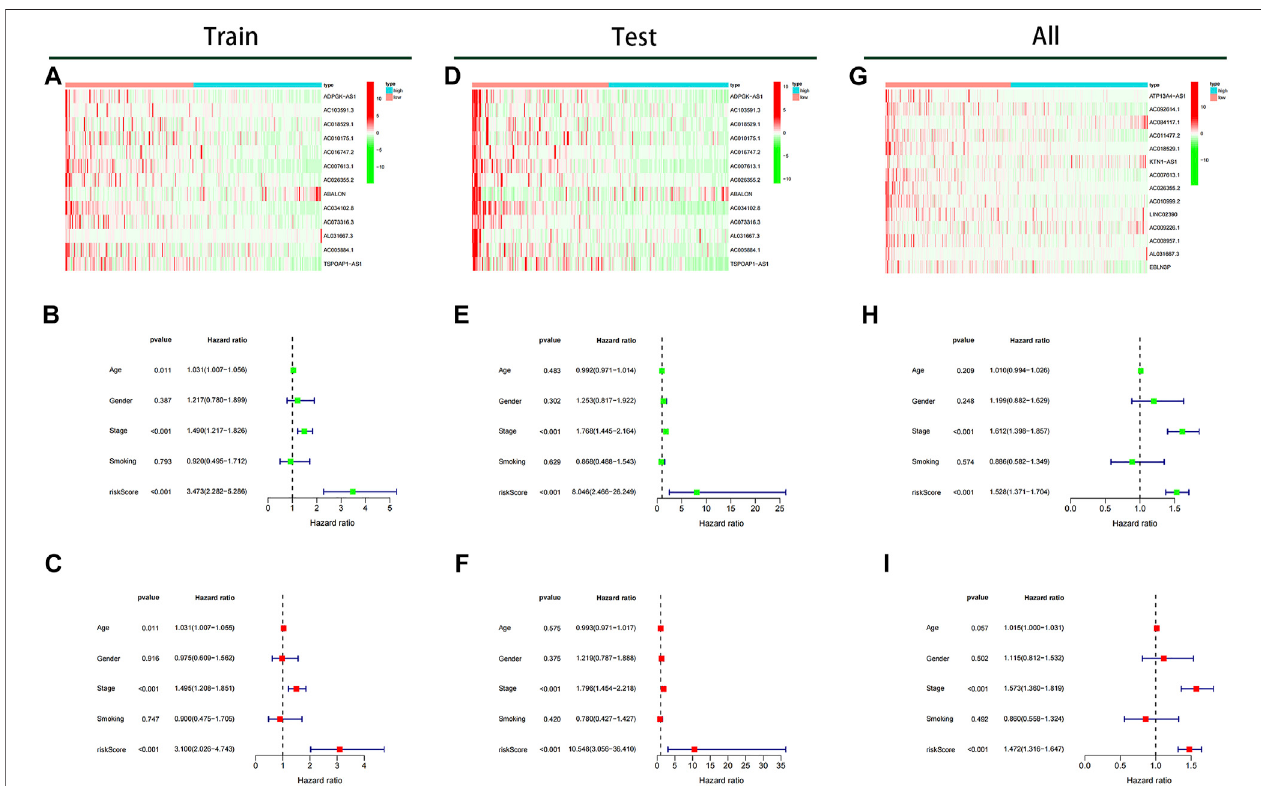
FIGURE 8 | The expression of 13 prognostic m6A-lncRNAs and analysis of prognostic factors. (A) Heatmap of expression of prognostic m6A-lncRNAs in the training cohort. Univariate (B) and multivariate (C) prognostic factors analysis forest plot of the model in the training cohort. (D) Heatmap of expression of prognostic m6A-lncRNAs in the test cohort. Univariate (E) and multivariate (F) prognostic factors analysis forest plot of the model in the test cohort. (G) Heatmap of expression of prognostic m6A-lncRNAs in the TCGA cohort. Univariate (H) and multivariate (I) prognostic factors analysis forest plot of the model in the TCGA cohort.